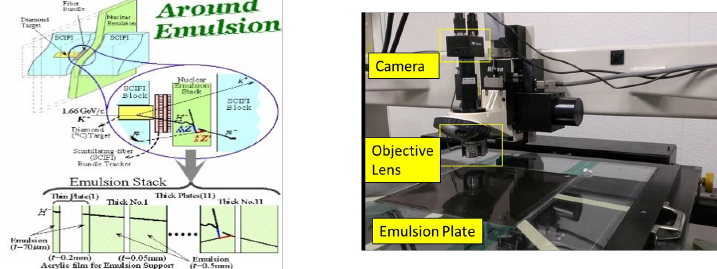
Figure 1. Right: The setup around the target area of the E373 experiment. Left: Photograph of the microscope system